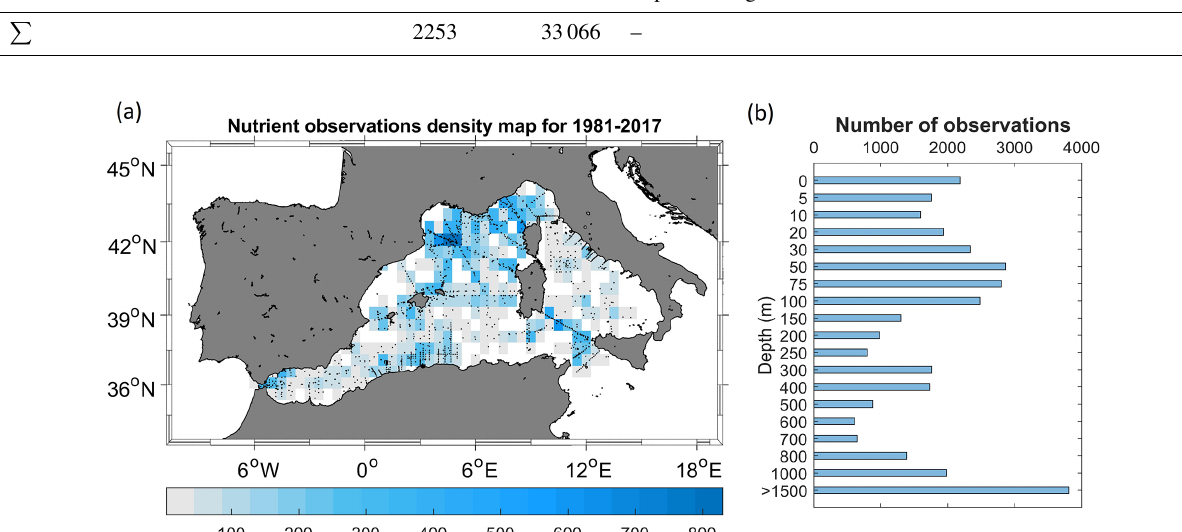
Figure 3. (a) Nutrient data density used for climatology analysis. Observations are binned in a regular 1 / 2 ◦ × 1 / 2 ◦ latitude–longitude grid for each year over the period 1981–2017. Locations of the stations included in the analysis are shown as black dots. (b) Data distribution per depth range (i.e., at 800m, observations between 800–1000m are